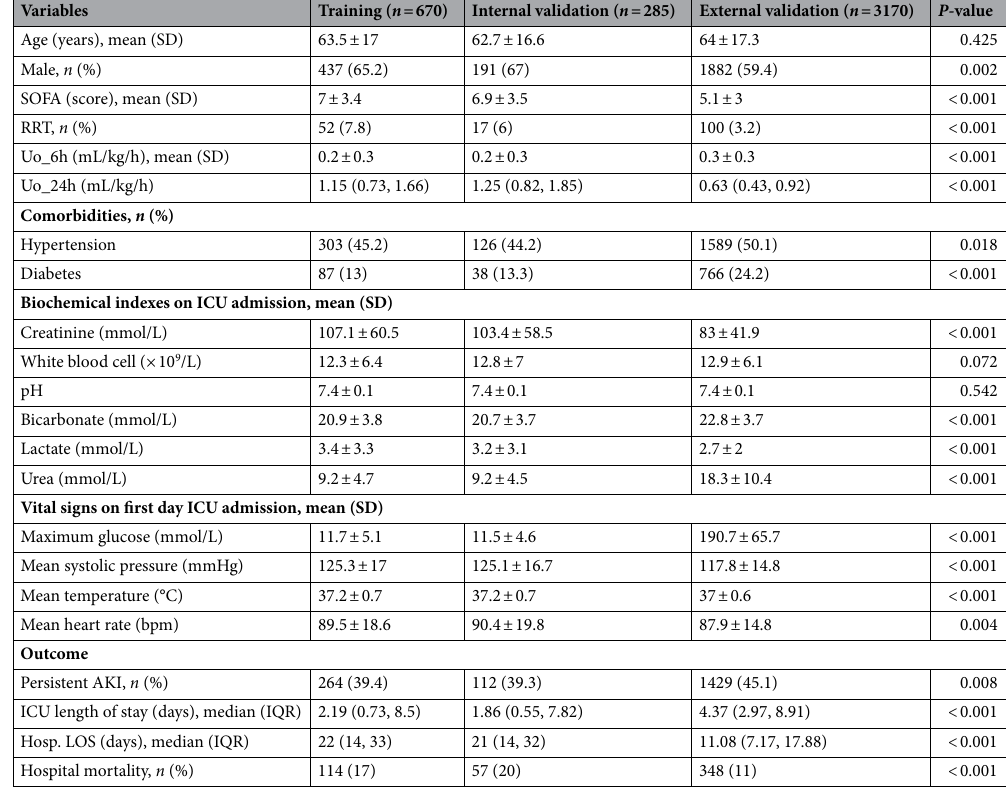
Table 1. Comparison of feature distributions between the training, internal validation, and external validation sets. SOFA, Sepsis-related Organ Failure Assessment; RRT, renal replacement therapy; Uo_6h, urine volume for 6 h on ICU admission; Uo_24h, urine volume for 24 h on ICU admission; ICU, intensive care unit; AKI, acute kidney injury; Hosp. LOS, length of hospital